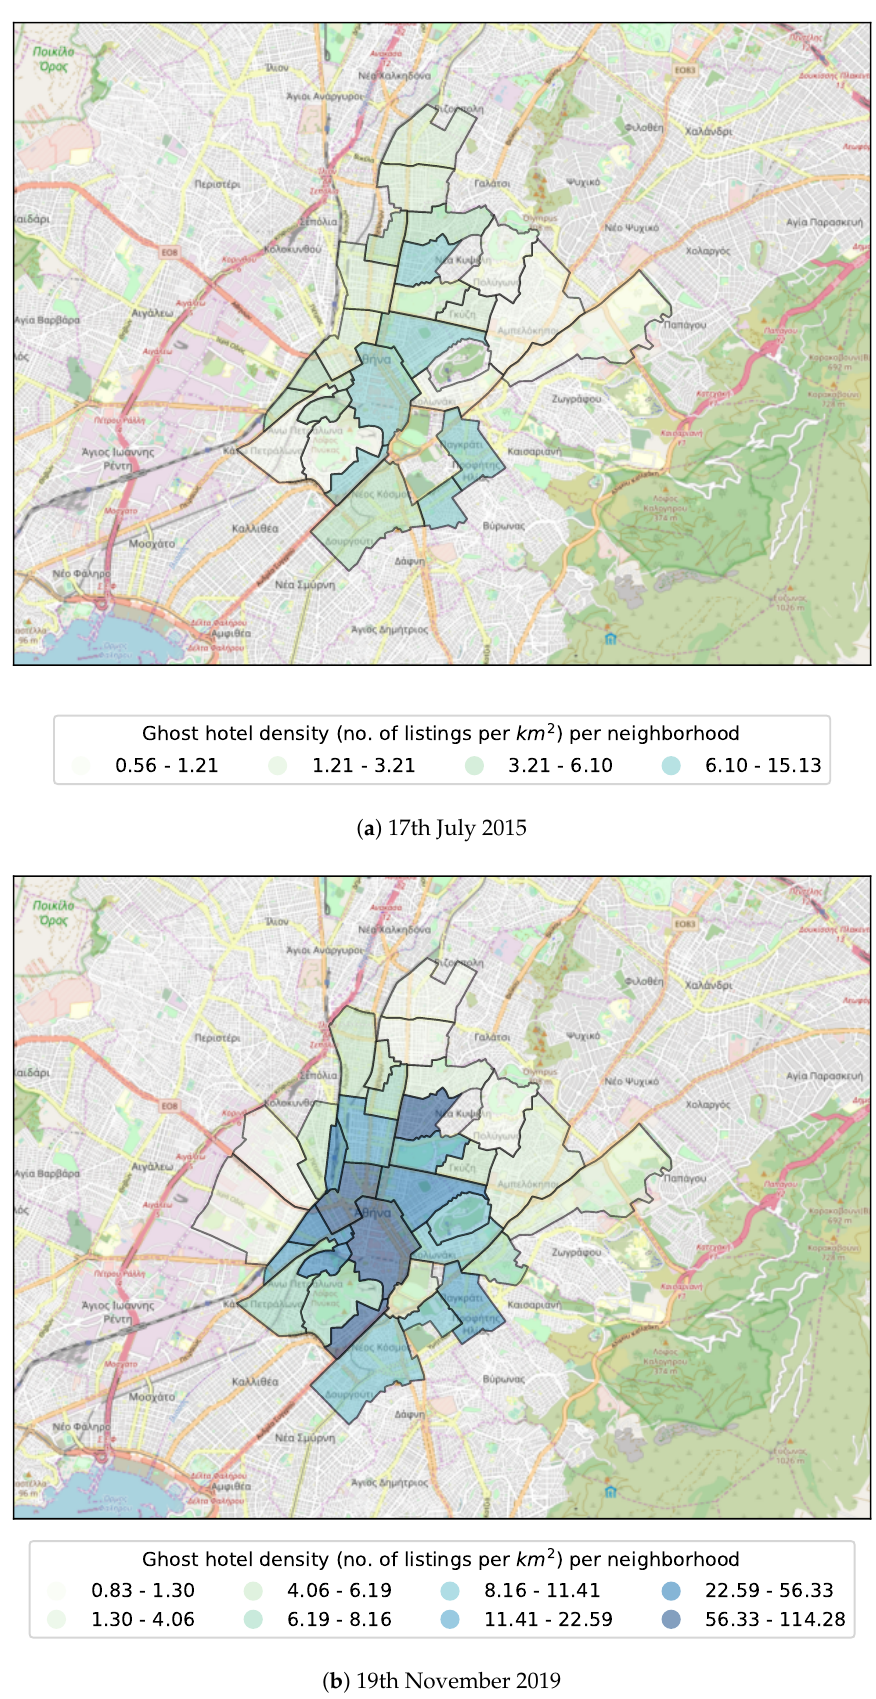
Figure 3. Change of ghost hotel density of Airbnb listings in Athens neighborhoods between 2015 and 2019 (color